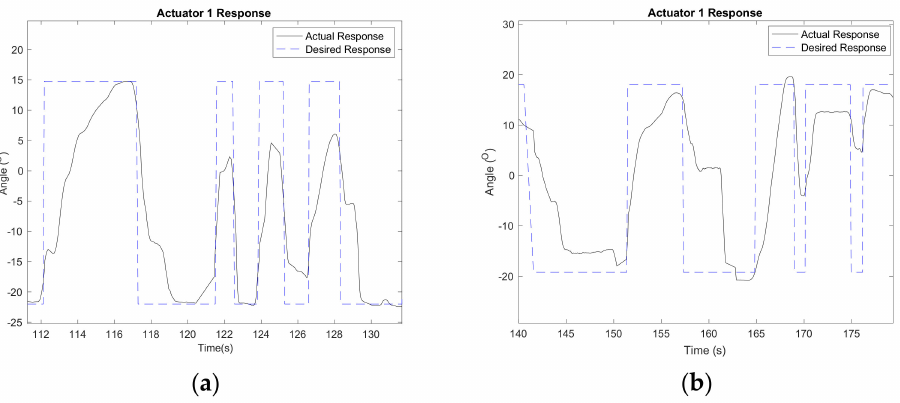
Figure 6. Actuator 1 response of the ( a ) healthy subject and ( b ) stroke patient during the game. The actuators were able to generate displacement between 2.29 mm and 36.71 mm with minor deviations (Table 1). The largest average error was 0.37 mm, and the smallest average error was 0.02 mm, which corresponds to errors of 0.49 ◦ and 0.03 ◦ . These differences could be attributed to the incompatibility between the tall chair, the subject’s height and the